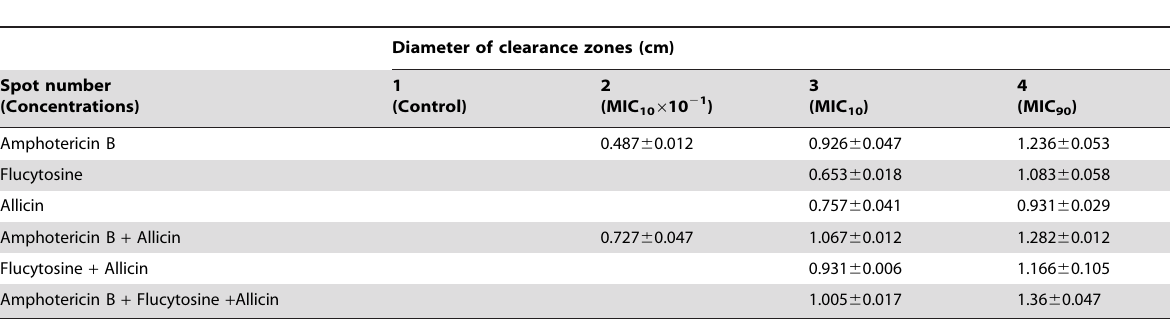
Table 1. The diameter of clearance zones according to treatment